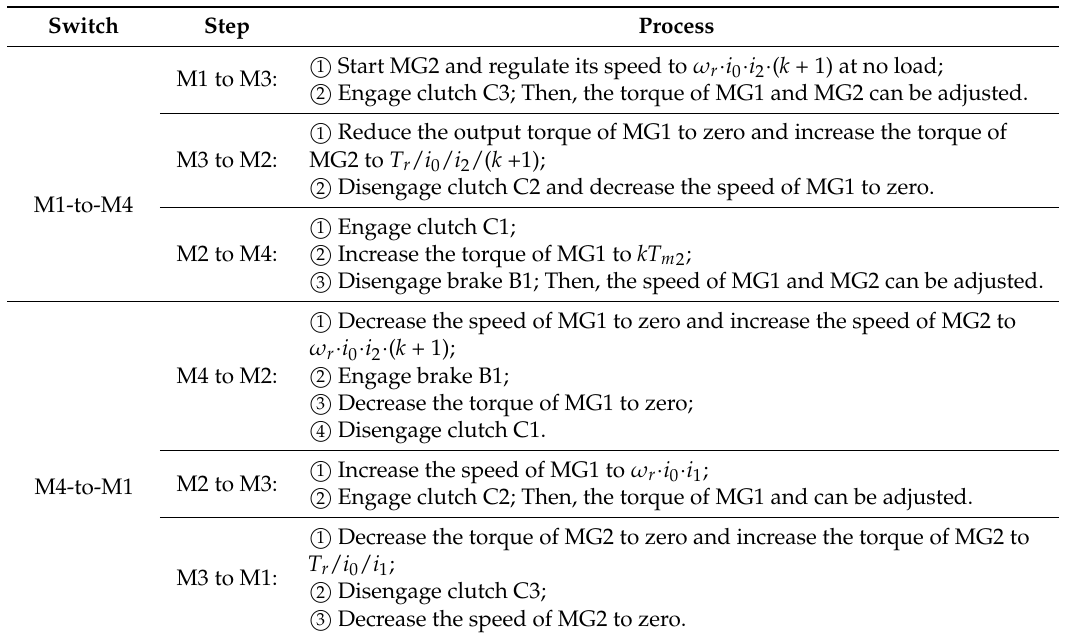
Table 4. Switching process between single motor 1 drive (M1) and